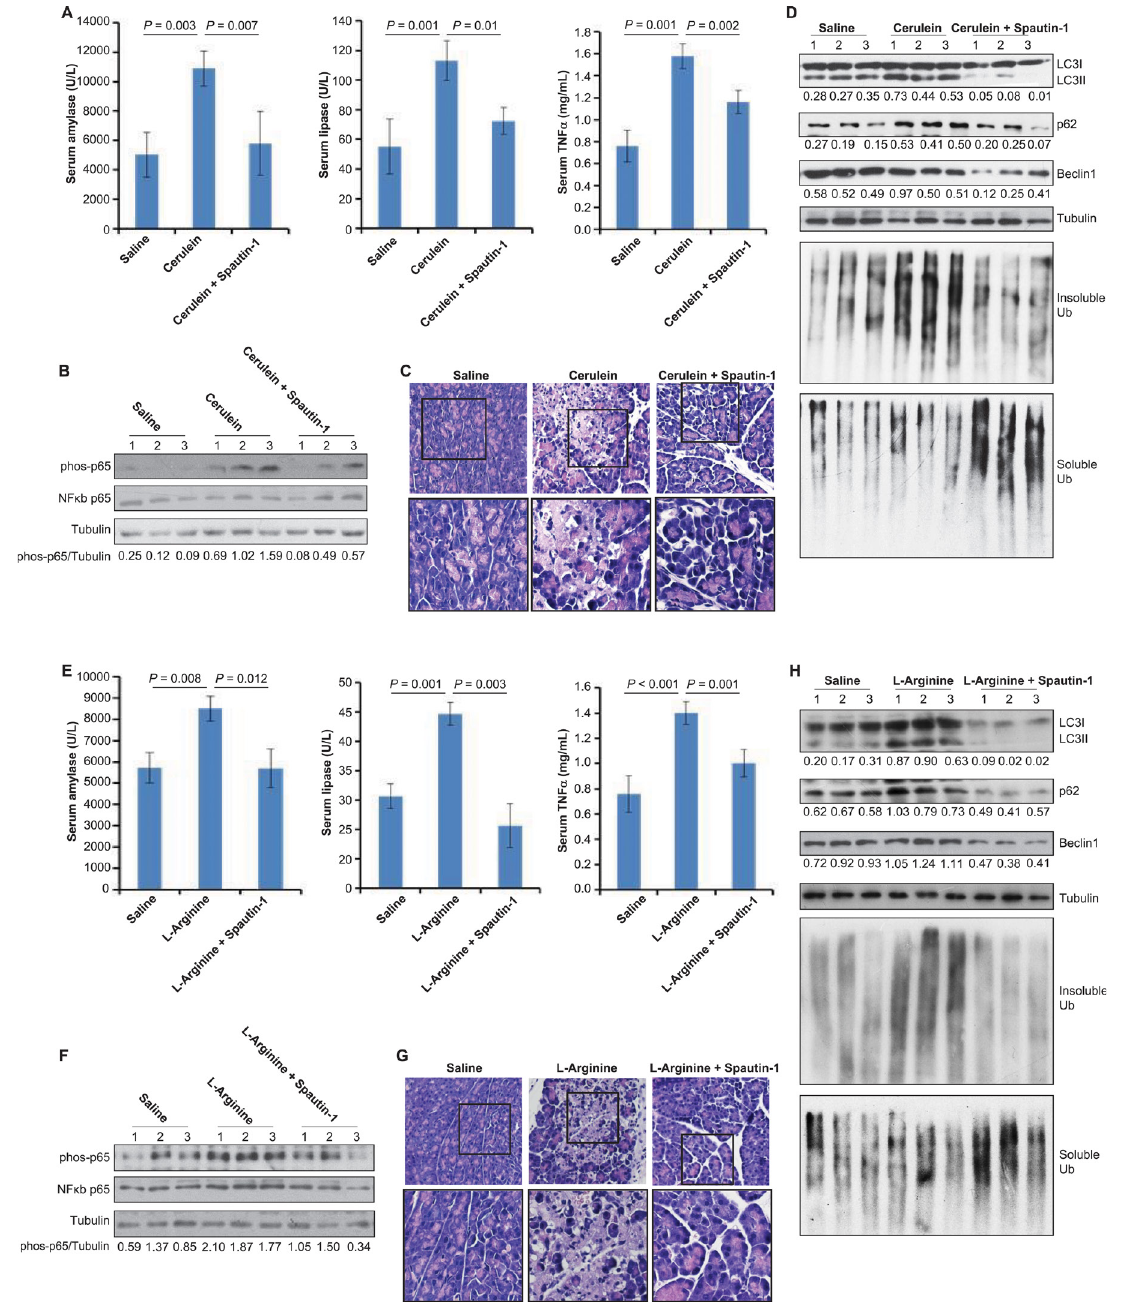
Figure 3. Spautin-1 ameliorates the pathogenesis of acute pancreatitis induced by cerulein or L-arginine in mice. (A–D) Cerulein-induced mice model with acute pancreatitis. Spautin-1 was injected half an hour before the first injection of cerulein. The mice were sacrificed nine hours after the last cerulein injection for analyzing serum amylase, lipase and TNF α levels (A), histopathological change (C) and the levels of p65 (B), LC3II, p62, beclin1 and Ub (D) in the pancreatic tissues. The data from serum analyses were tested using one-way ANOVA with LSD corrections and shown as means ± SD. (E–H) L-arginine-induced mice model with acute pancreatitis. Spautin-1 was injected 30 min before the first injection of L-arginine. The mice were sacrificed nine hours after the last L-arginine injection for analyzing serum amylase, lipase and TNF α levels (E), histopathological change (G) and the levels of p65 (F), LC3II, p62, beclin1 and Ub (H) in the pancreatic tissues. The data from serum analyses were tested using one-way ANOVA with LSD corrections and shown as means ± SD. The ratios between the level of relative protein and tubulin are listed below the